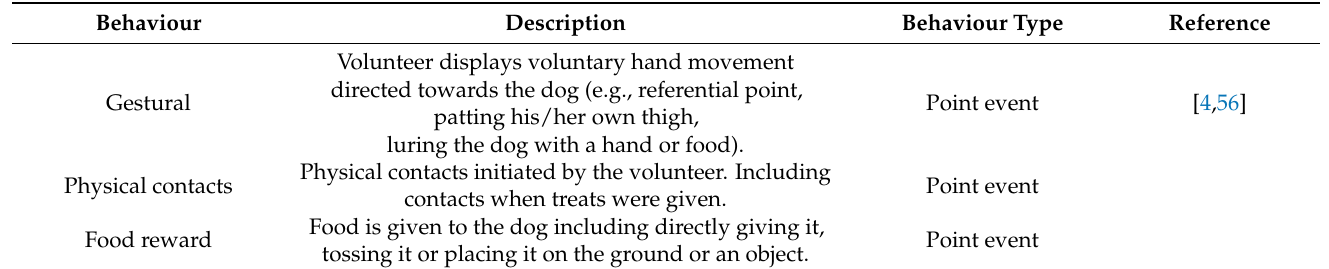
Table 4. Ethogram of human body language